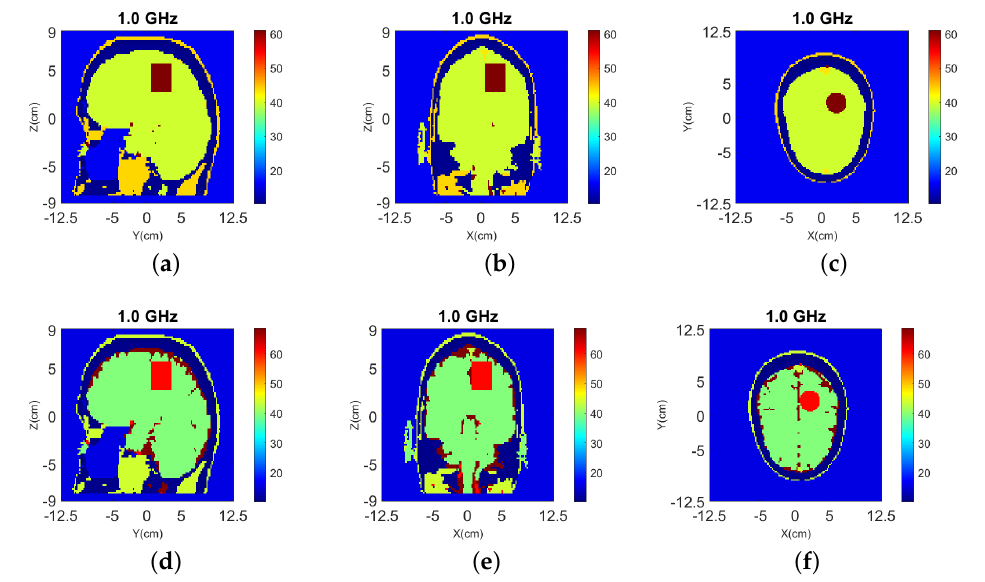
Figure 11. True values of (cid:60) ( ε r ) of Case II.1 and II.2 at 1.0 GHz: ( a ) y-z slice, ( b ) x-z slice, and ( c ) x-y slice of Case II.1. ( d ) y-z slice, ( e ) x-z slice, and ( f ) x-y slice of Case II.2.